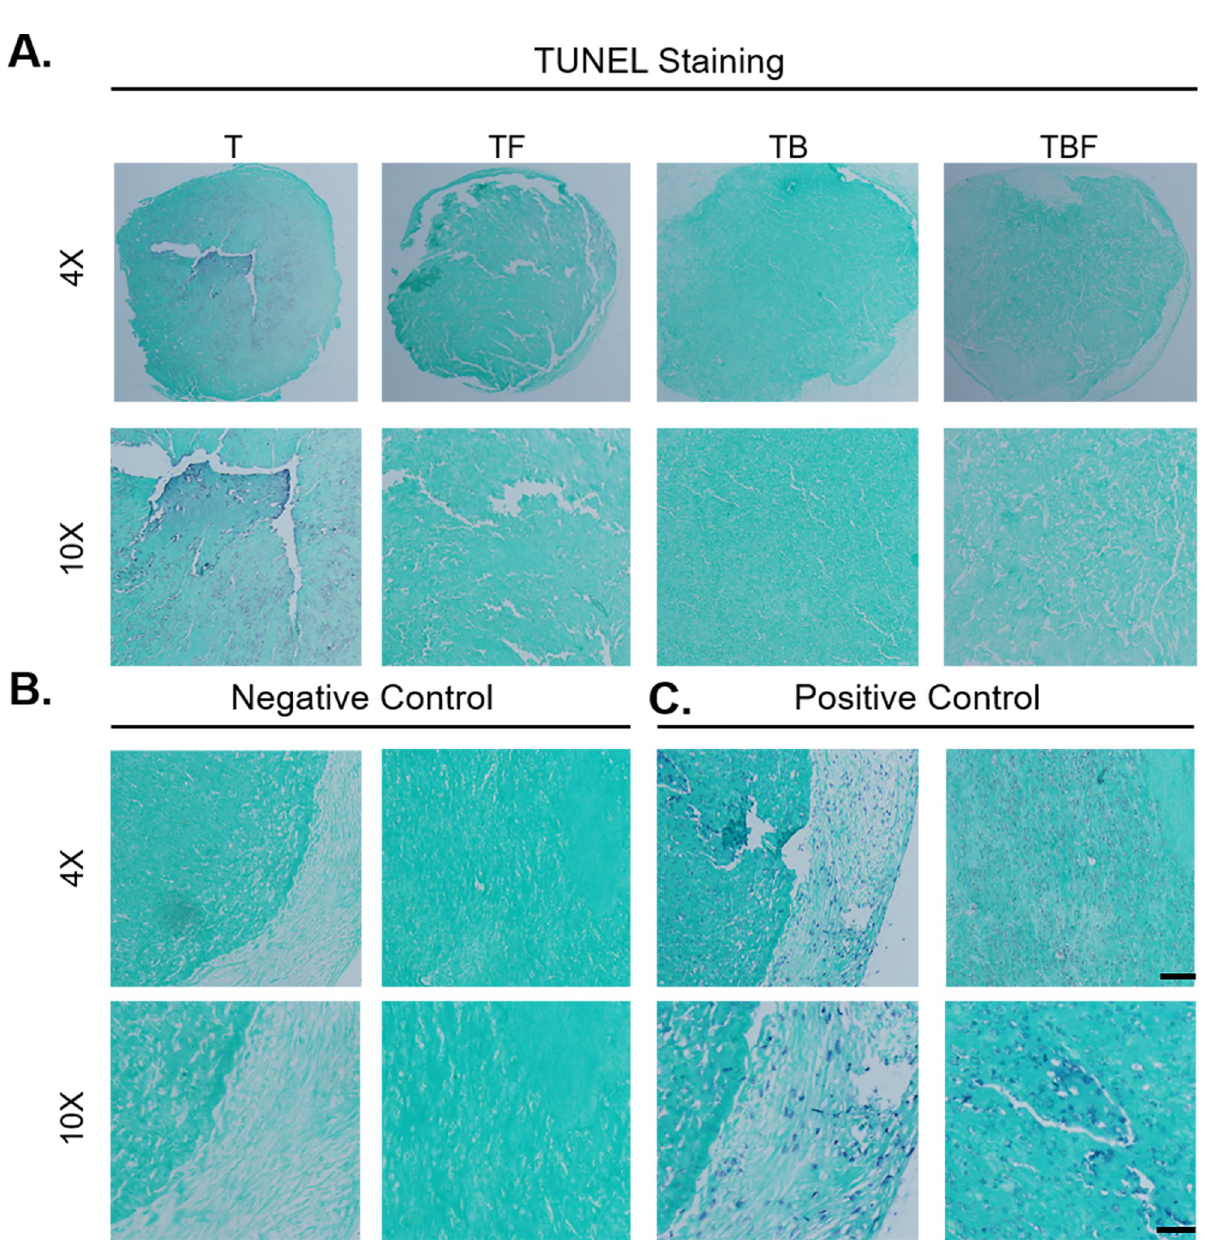
Fig 10. TUNEL staining. Constructs were cultured for 21 days prior to fixation and processing for histology and immunofluorescence as described in Figs 8 and 9. Sections for each treatment group were evaluated using the TUNEL method. All sections were counterstained with 0.5% Light Green stain. A) Positive staining was observed within the central region of treatment group T, with strong signal within the construct core. Staining was not observed in treatment groups TF, TB, or TBF. B) Negative controls were incubated with label solution lacking terminal transferase. C) Positive control slides were generated by applying recombinant DNase I to sections to induce DNA strand breaks, followed by incubation with TUNEL reaction mixture. Bars = 500 μ m (4X) and 200 μ m (10X).